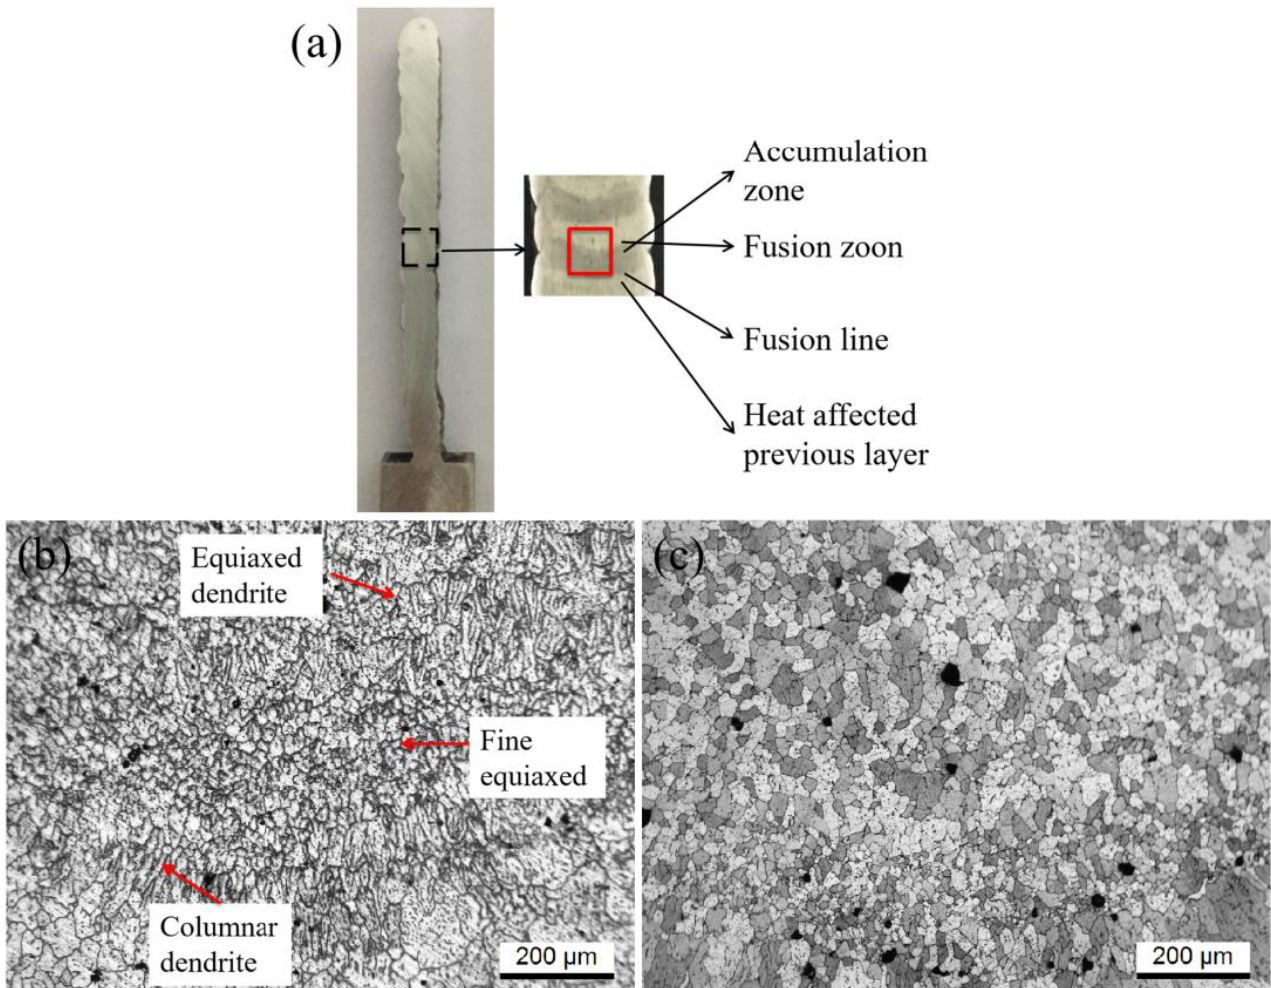
Figure 4. ( a ) The sampling positions of the wall; OM images of WAAM 2219 alloys ( b ) as-deposited and ( c ) T6 and ( c ) T6 heat-treated.